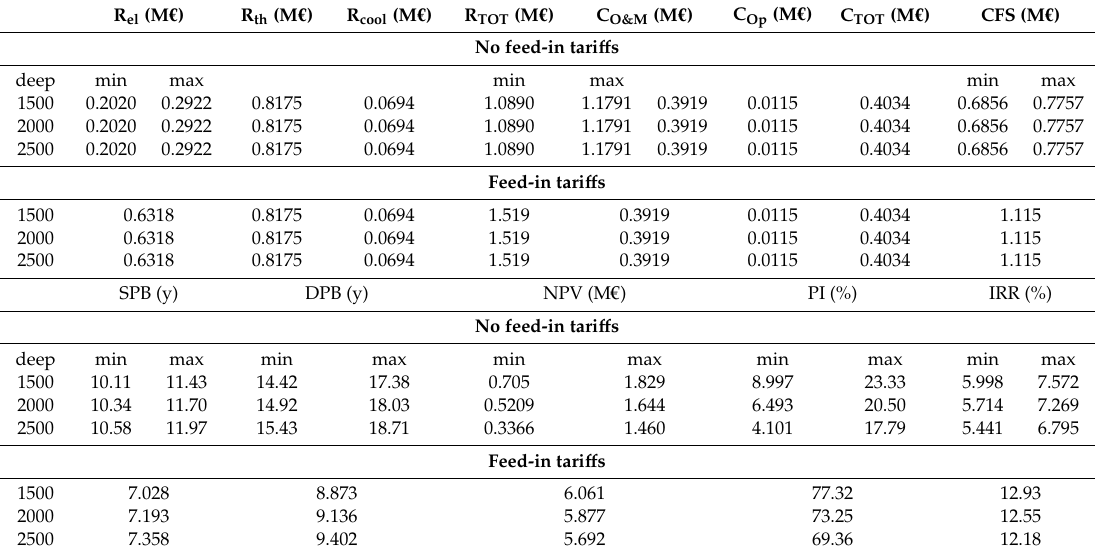
Table A8. Main results of the economic analysis (on a yearly basis; stop time of the DHCN at 22:00). R el (M € ) R th (M € ) R cool (M € ) deep min